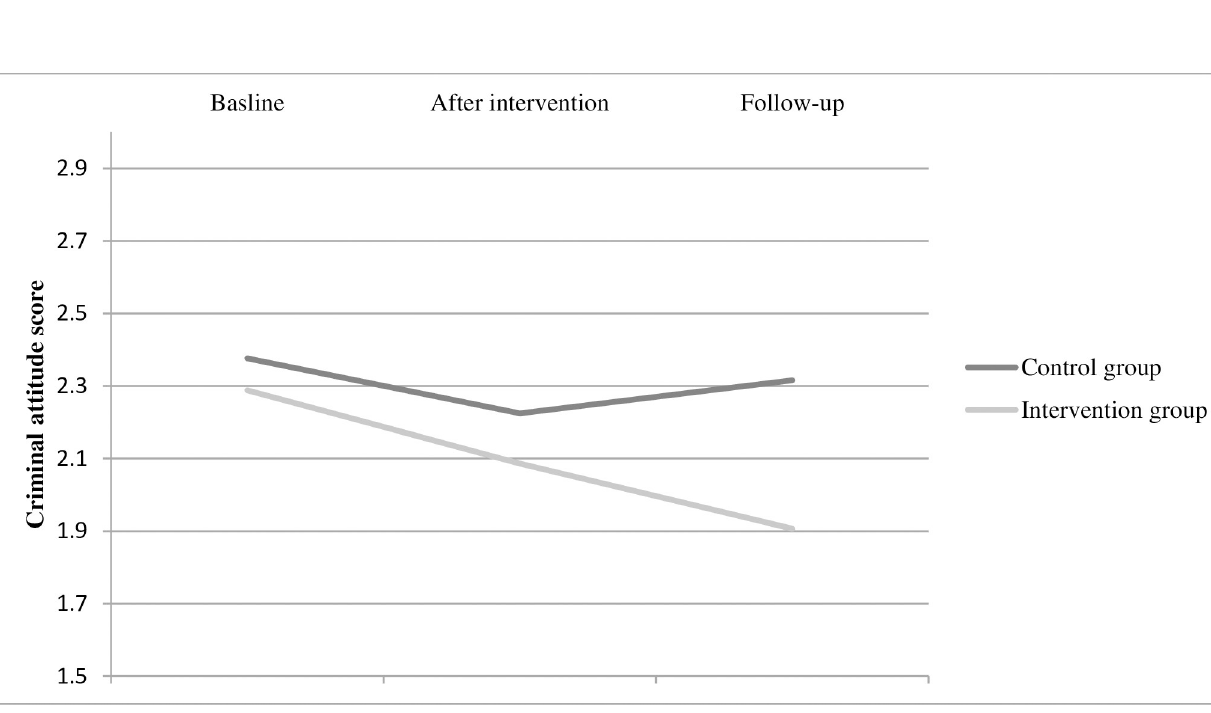
PLOS ONE | https://doi.org/10.1371/journal.pone.0283177 March 23,